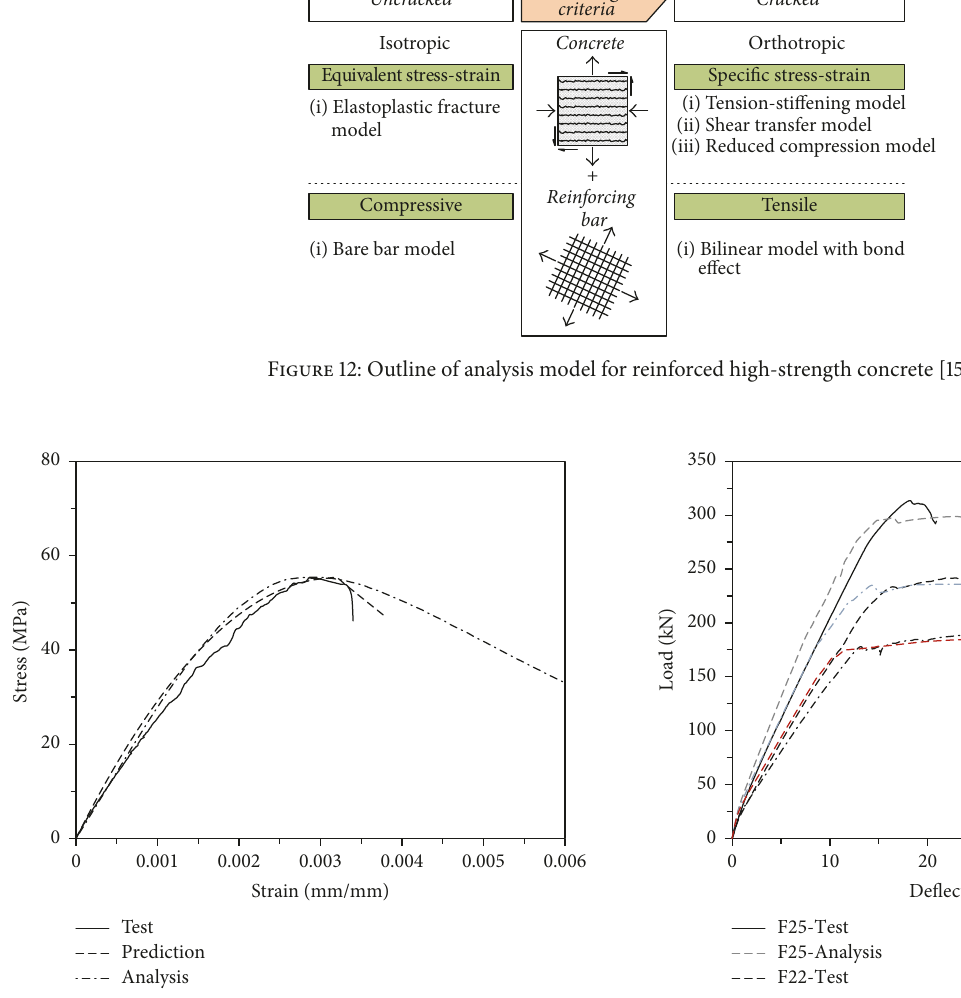
Figure 14: Comparison of experimental and analytical load- deflection curves for flexure test